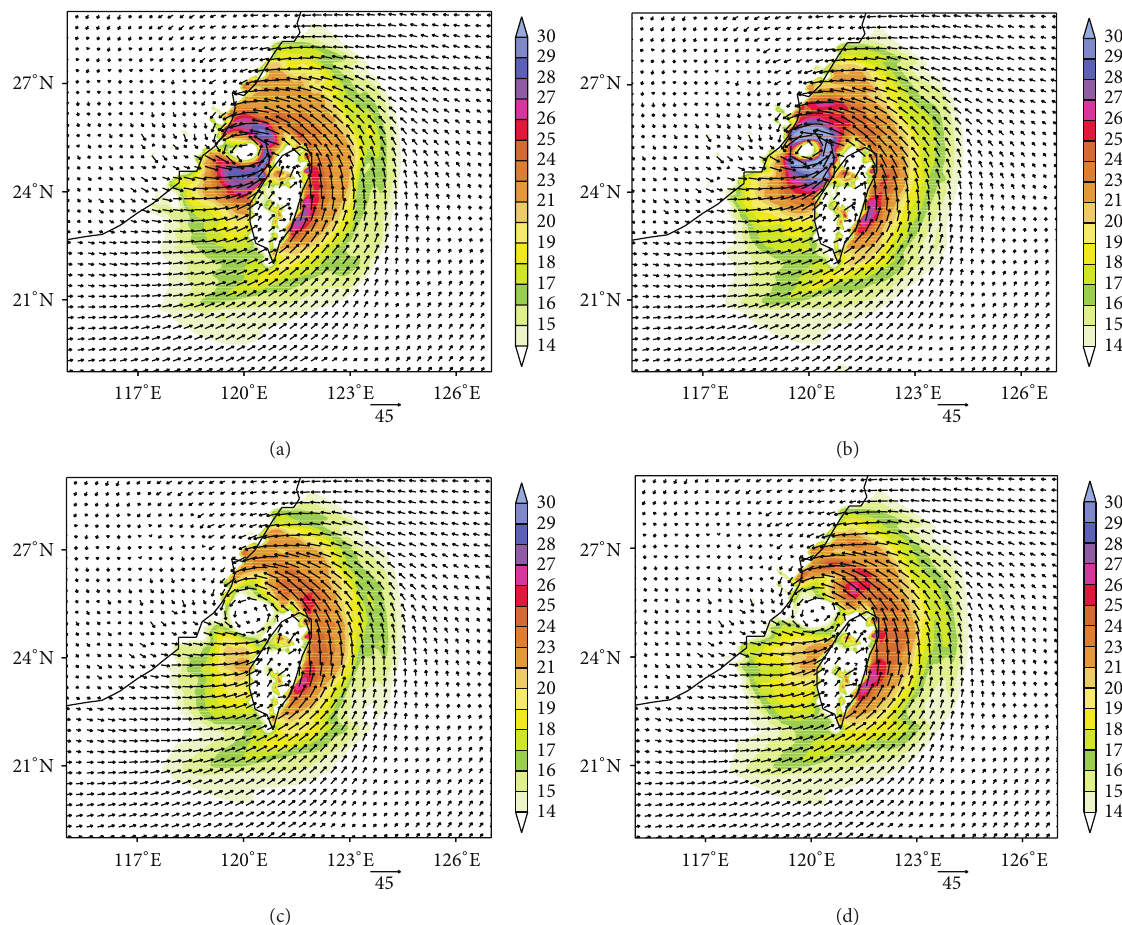
Figure 7: 10m wind (units: m s −1 ) for (a) CTRL, (b) No hflux, (c) No qflux, and (d) No flux at 0600 UTC 19 July 2005.